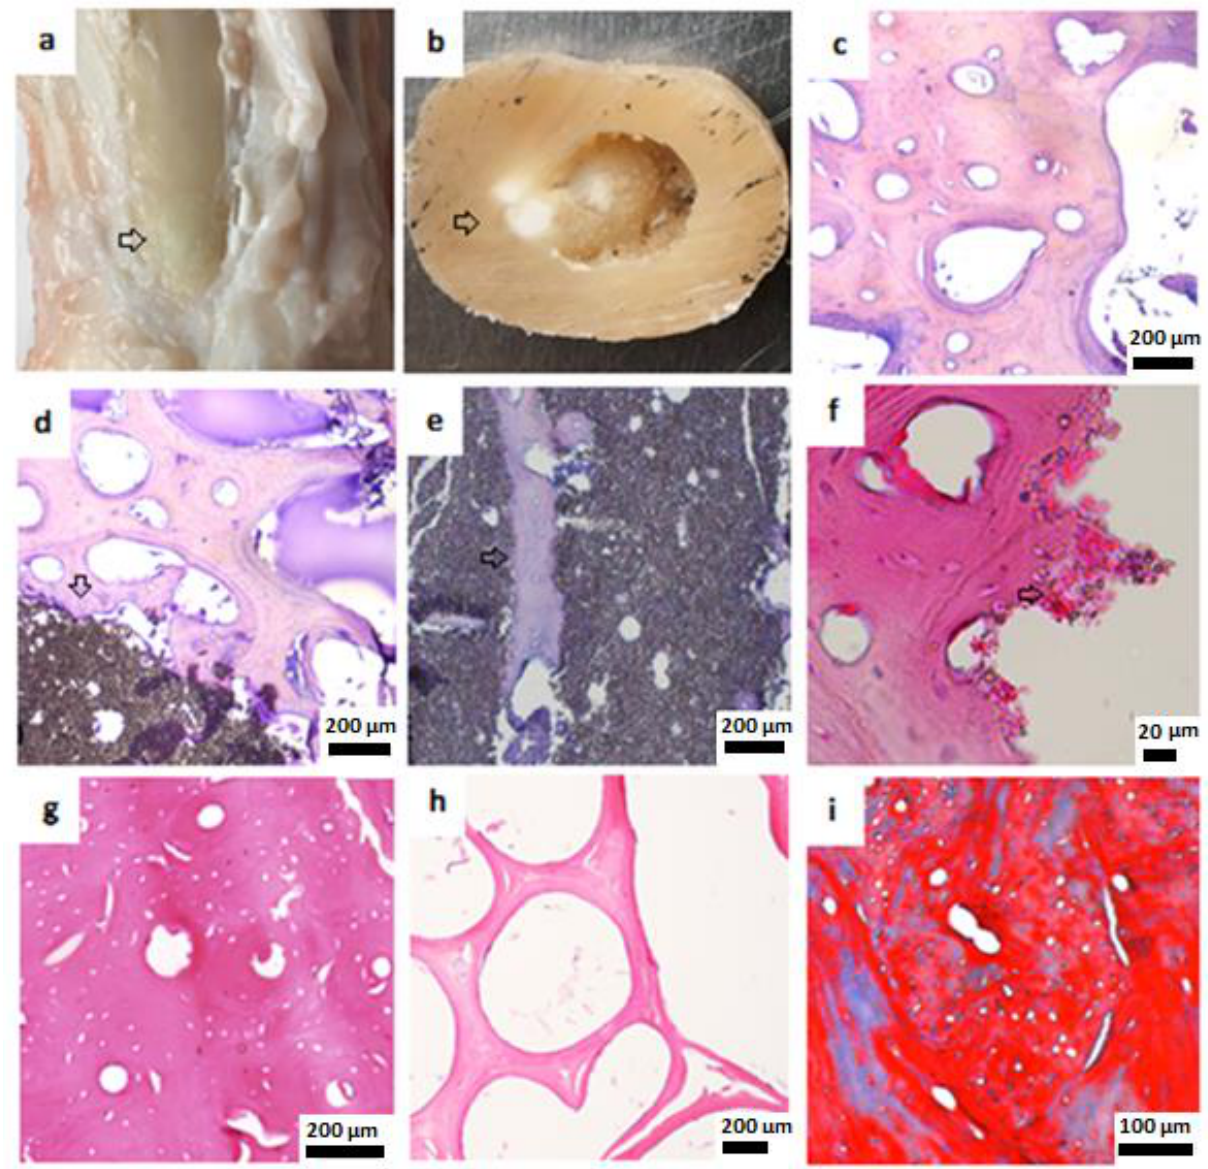
Figure 5. Macroscopic and histological examination of bone tissue 6 months after HA cylinder im‑ plantation. ( a ) Macroscopic view, metarsal bone after removal of soft tissue, arrow: the place where new bone was formed. ( b ) Macroscopic view, cross section of the metatarsal bone, arrow: unre‑ sorbed parts of HA cylinder. ( c ) Adjacent healthy cortical bone, haematoxylin–eosin staining (H&E), 200 µ m. ( d ) Cortical bone, H&E, arrow: HA cylinder, 200 µ m. ( e ) Islets of bone tissue in HA cylinder, H&E, 200 µ m, arrow shows new bone formation inside the HA cylinder. ( f ) New bone formation around HA cylinder, H&E, 20 µ m. ( g ) Newly formed cortical bone, H&E, 200 µ m. ( h ) Newly formed trabecular bone, H&E, 200 µ m. ( i ) Newly formed cortical bone, Masson’s trichrome, 100 µ